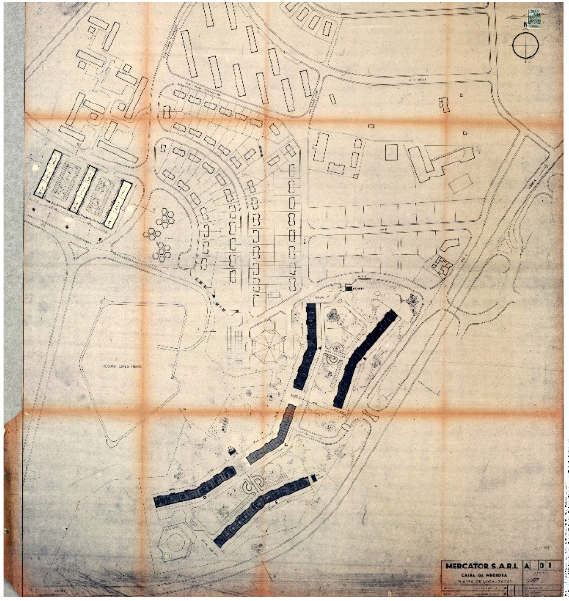
Figure 7. Urbanisation plan of Alto da Barra Neighbourhood (drawing). Source: Silva